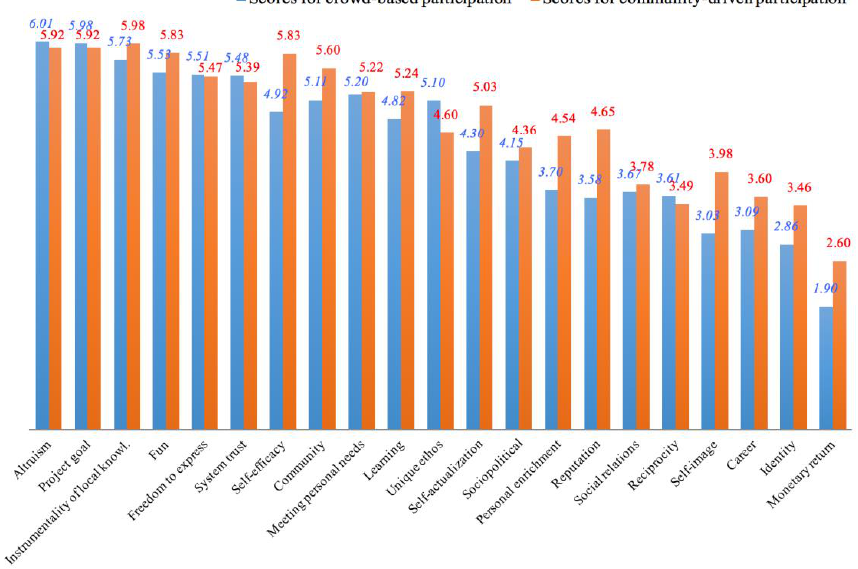
Figure 5. Mean Scores of Motivational Factors for Contributing to OSM Participating as a Crowd versus Community-Type User. Figure created based on published data in Budhathoki and Haythornthwaite [44].